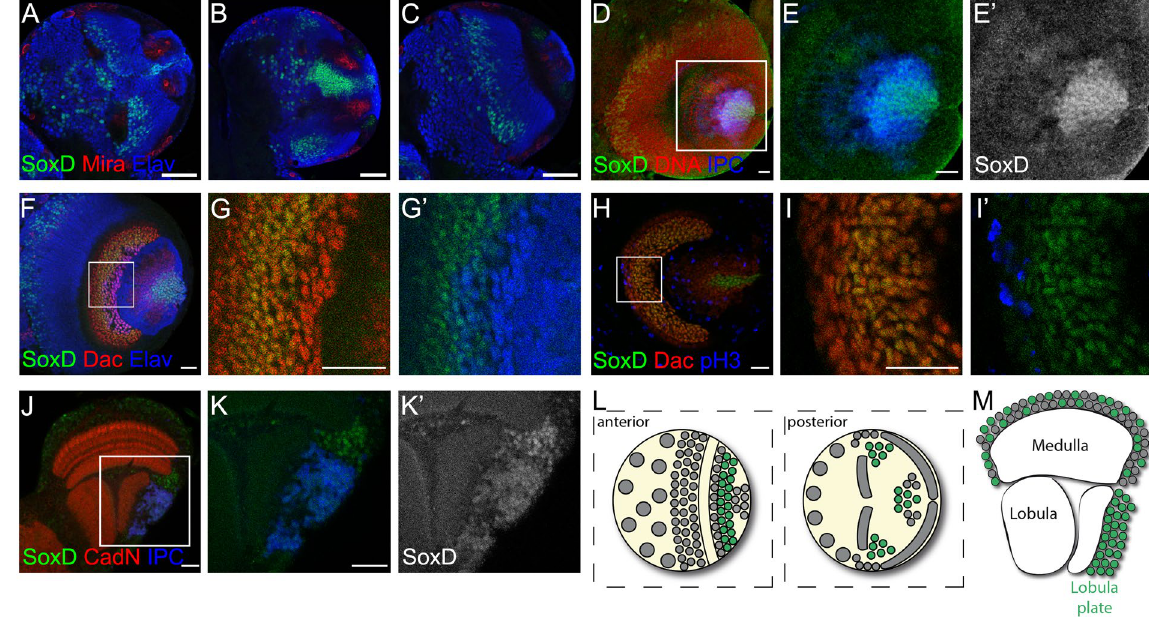
Figure 3. SoxD protein is found in medulla neurons, lobula complex neurons and lamina progenitors. ( A – C ) Immunofluorescence of Sox:GFP (green) larval brains stained for Mira (red) and Elav (blue), different sections in the antero-posterior axis are shown. ( D – G ) Staining of larval brains expressing IPC-LexA, LexAop-mCherry (blue), SoxD:GFP (green) and DNA (red), lateral view. ( F–I’ ) Staining of SoxD:GFP (green) larval brains for Dac (red) and ( F,G’ ) Elav (blue) or ( H,I’ ) pH3 (blue), lateral view. ( J,K’ ) Immunofluorescence of an adult optic lobe of IPC-LexA, LexAop-mCherry (blue), SoxD:GFP (green) genotype and co-stained for CadN (red), lateral view. Scale bars are ( A–C ) 50 µ m and ( D–K ’) 20 µ m. ( L,M ) Schematic representation of the ( L ) larval and ( M ) adult optic lobe showing expression of SoxD in green, horizontal